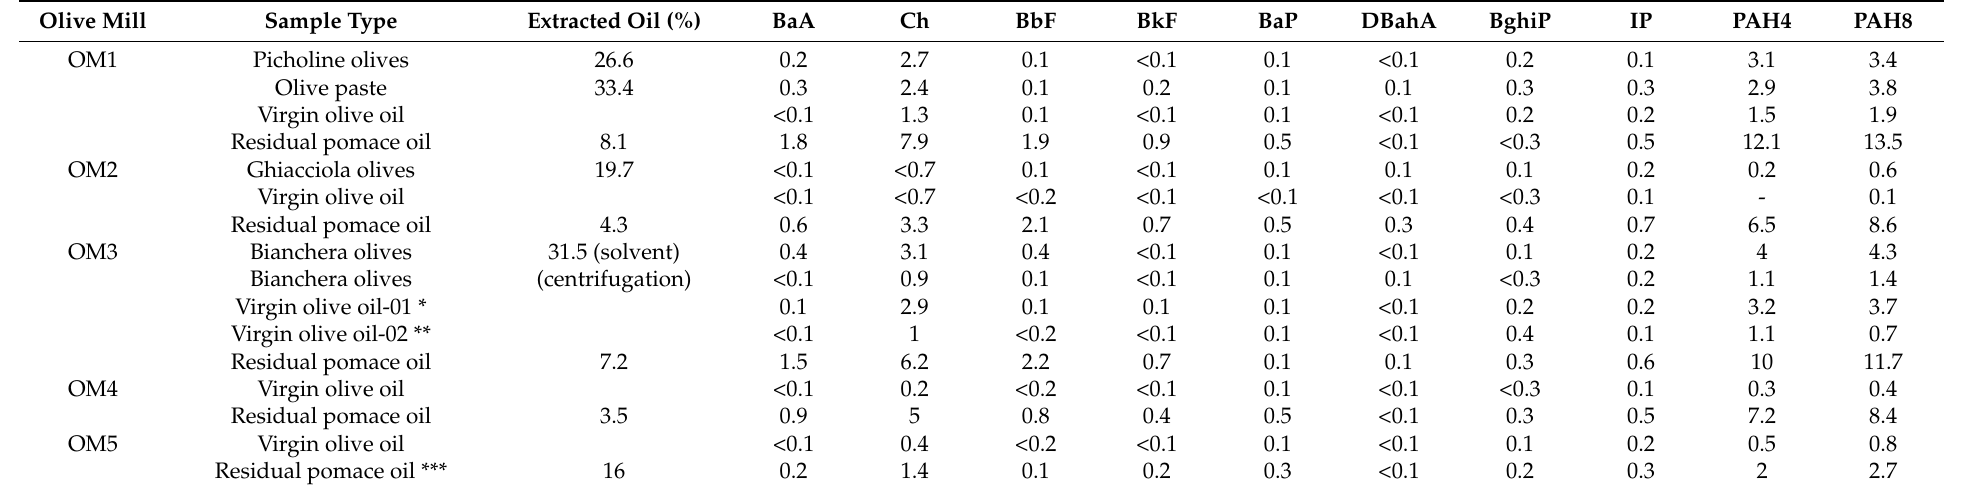
Table 3. PAHs content ( µ g/kg) of samples collected in different olive